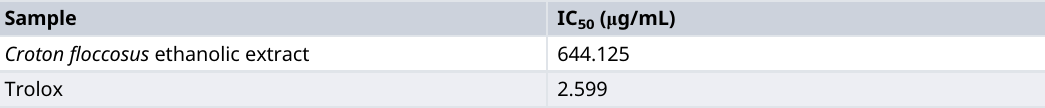
Table 10. Comparison of inhibition coefficients for Croton floccosus and